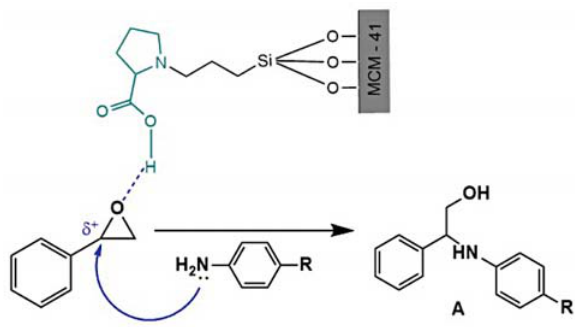
Table 3. Synthesis of β -Amino alcohols by the ring opening of styrene oxide with aniline derivatives over (L-prol-N-pMCM-41) catalyst.